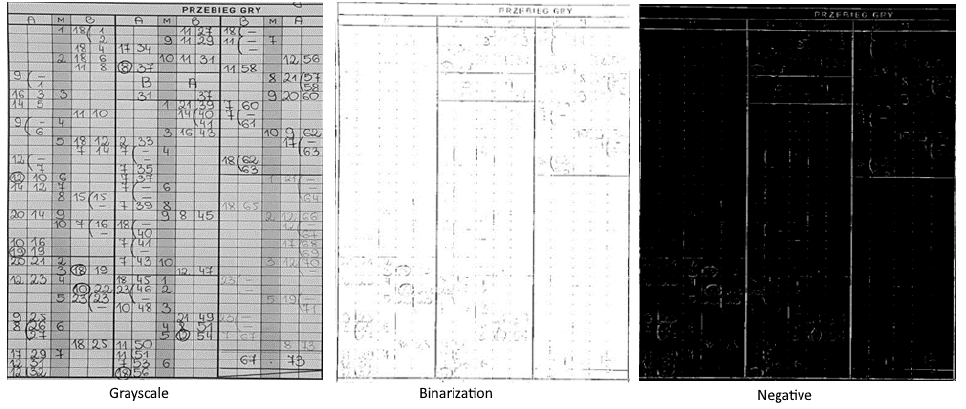
Figure 7. Prefiltering of the protocol.